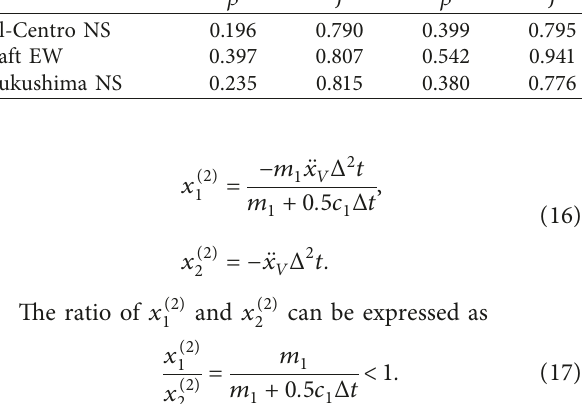
Table 2: Results of the evaluation indices. Seismic